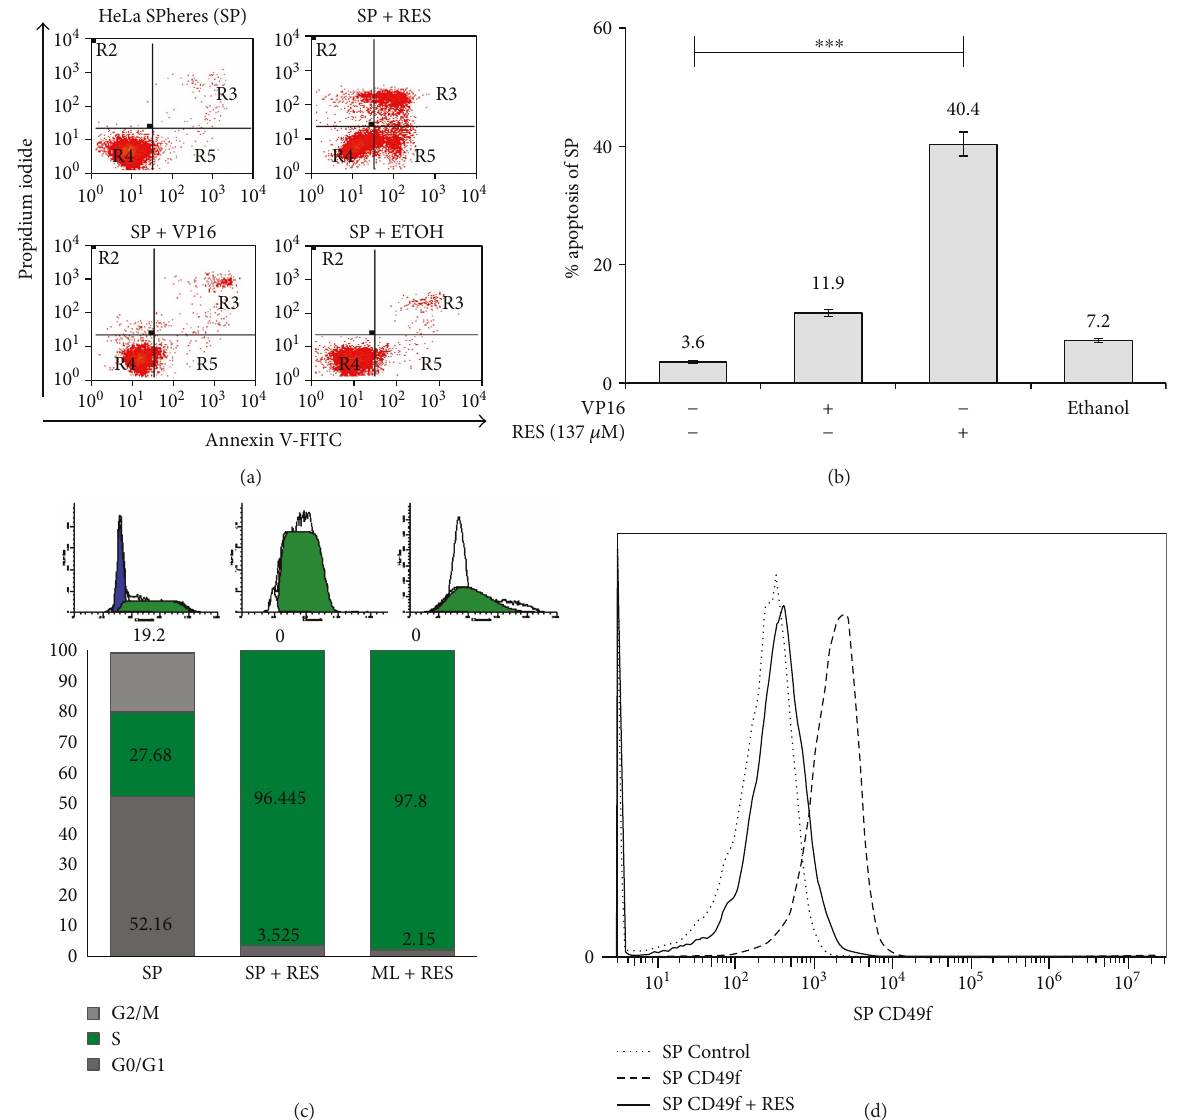
Figure 5: Resveratrol decreases viability and increases apoptosis of sphere cultures. (a and b) RESveratrol (RES) induces higher apoptosis levels of HeLa SPhere (SP) cultures compared to controls. Ethanol was used as vehicle. Apoptosis was evaluated by Annexin-V assay. (c) RES induced cell cycle arrest at S phase in both HeLa ML and SP cultures. HeLa cells under both conditions were treated with 137 μ M of RES for 72h, and then, cells were harvested and stained with propidium iodide (PI) for 30 min at 37 ° C. Cells were then subjected to fl ow cytometric analysis to determine the cell distribution at each phase of the cell cycle. (d) Graphics show fl uorescence distribution for antibody isotype (control) and CD49f-PE antibody. Histogram graphs show that CD49f-positive subpopulation decreases signi fi cantly when HeLa SP enriched in CSC are treated with resveratrol for 72 h (from 84% to 16%). The detection of CD49f cells involves the fi xation and stain with CD49f-PE antibody for 45min or isotype (see Materials and Methods). ∗∗∗ p < 0 001